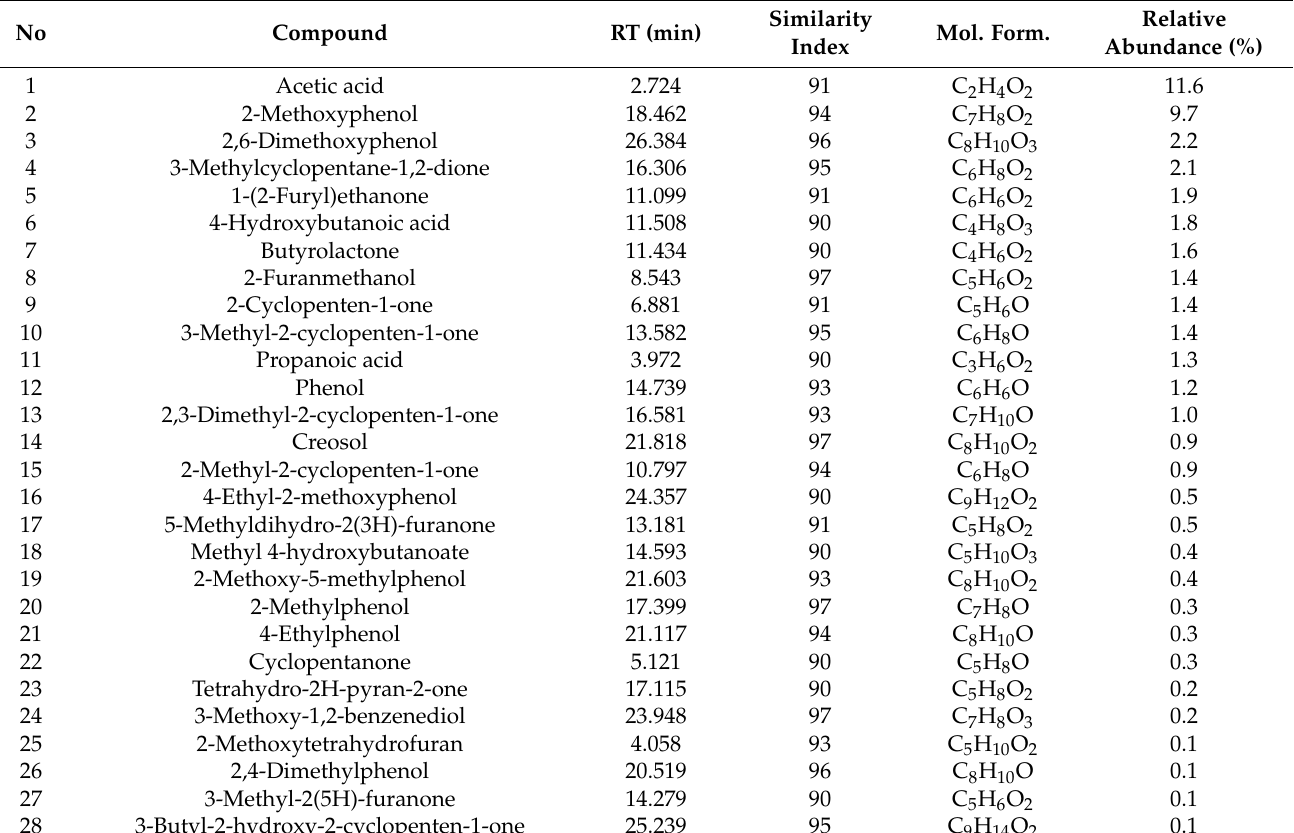
Table 10. Chemical composition of hemp root (RT2) distillates from pyrolysis stage (PS) condensed at 70 ◦ C and analyzed by